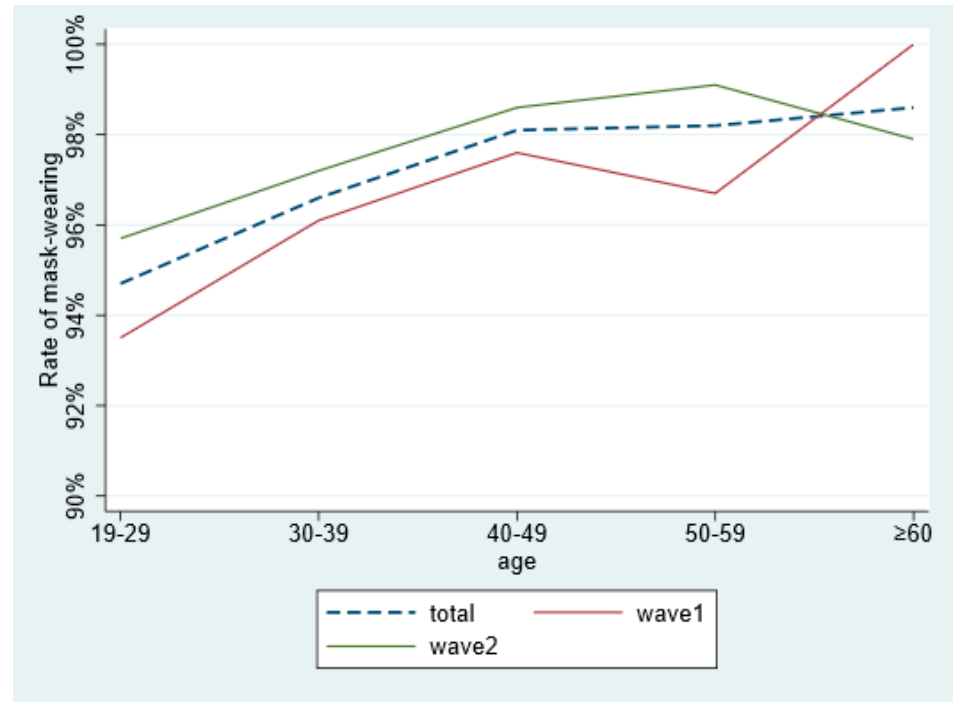
Figure 1. Comparison of the rate of wearing masks in respondents with different age in two surveys.